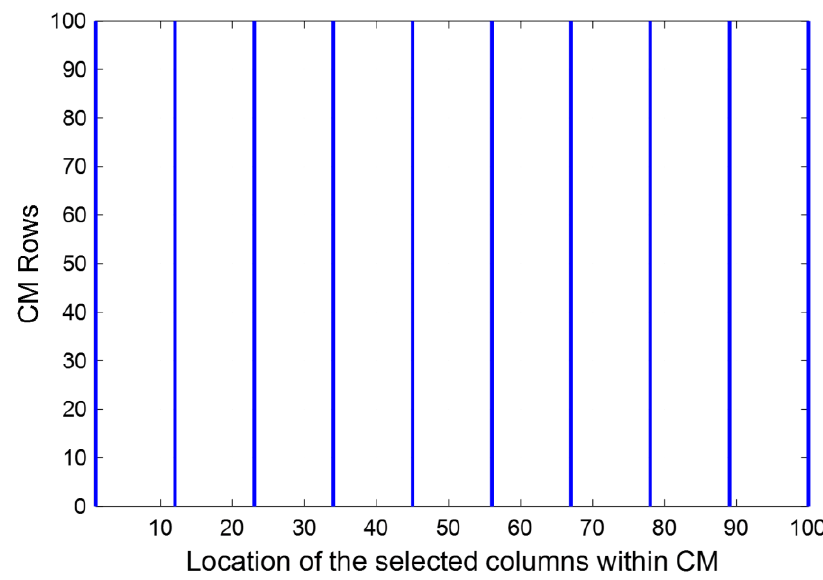
Figure 3. Conceptual diagram of selected columns of 𝑸 𝑼𝑺𝑴 with L = 9, M = 100 and C = 10.